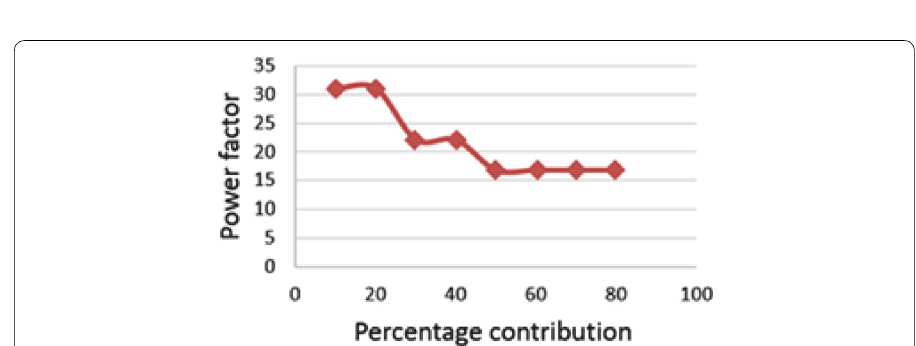
Fig. 11 Power factor versus percentage contribution of geothermal energy to the total energy